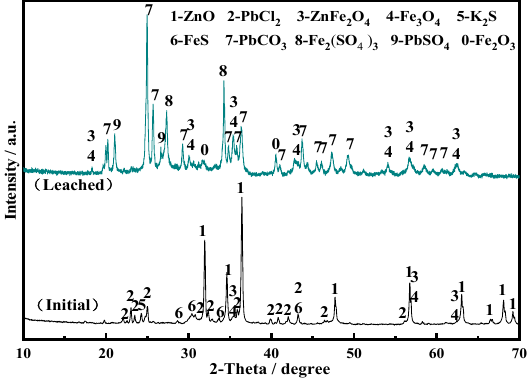
Figure 9. ( a ) Thermogravimetric-differential thermal curve of basic zinc carbonate ( b ) XRD and SEM of the product calcined at 500 °C for 60 min.